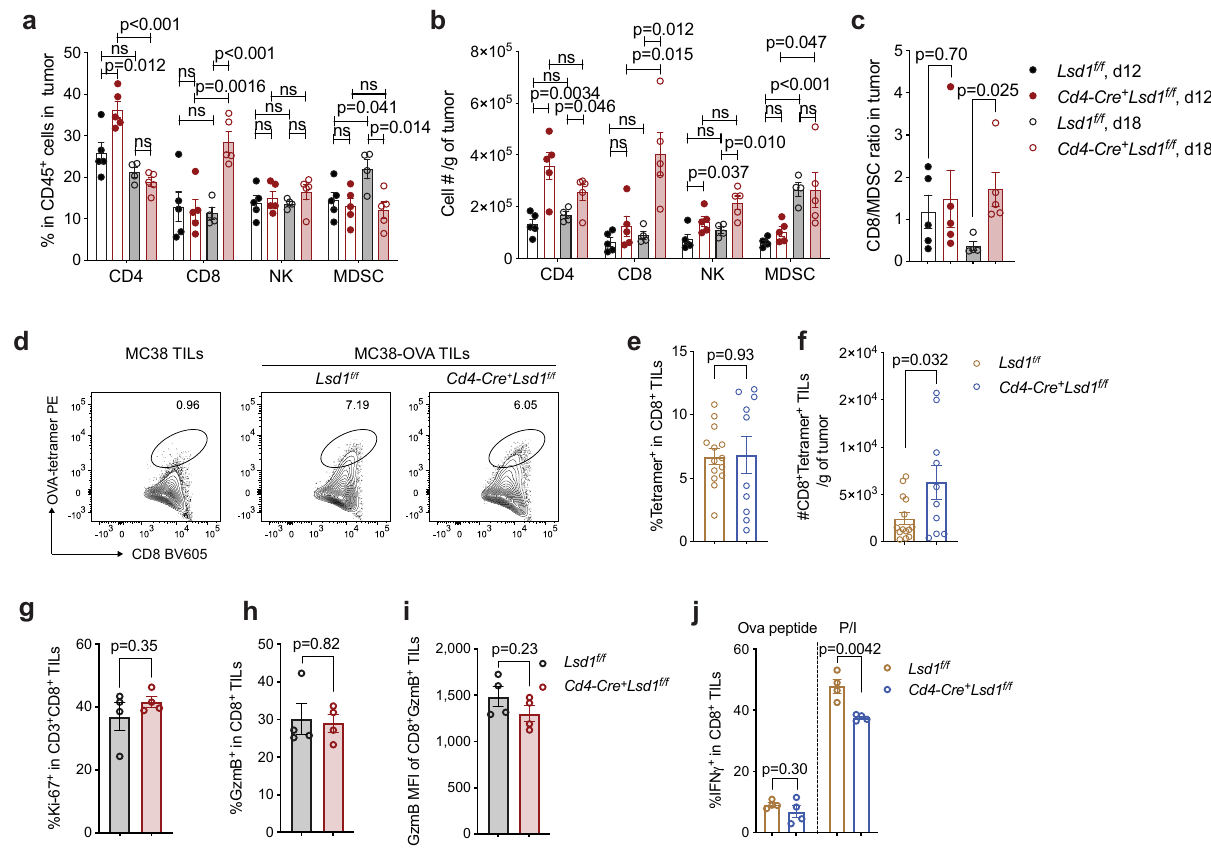
Fig. 2 LSD1 depletion results in sustained tumor in fi ltration of CD8 + T cells. a , b Frequencies of tumor-in fi ltrating CD3 + CD4 + T cells, CD3 + CD8 + T cells, CD3 - CD49b + natural killer (NK) cells and CD11b + Gr1 + myeloid-derived suppressor cells (MDSCs) among gated CD45 + leukocytes ( a ) and cell numbers per gram of tumor ( b ) analyzed by fl ow cytometry on day 12 and 18 after MC38 tumor implantation in Lsd1 f/f and Cd4-Cre + Lsd1 f/f mice ( Lsd1 f/f d12 group, n = 5; Cd4-Cre + Lsd1 f/f d12 group, n = 5; Lsd1 f/f d18 group, n = 4; Cd4-Cre + Lsd1 f/f d18 group, n = 5). c Calculated ratios of intratumoral CD8 + T cell number over MDSCs ( n = 5, 5, 4, or 5, respectively). d – f Representative fl ow plots ( d ), percentages ( e ) and cell numbers ( f ) of CD8 + Tetramer + TILs in